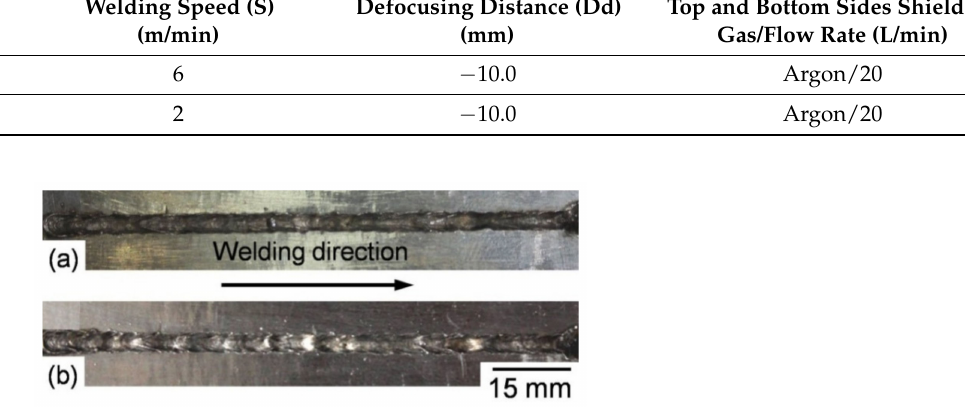
Table 3. Welding parameters used for producing low and high heat input autogenous square butt-welded joints. Power (P) (kW);